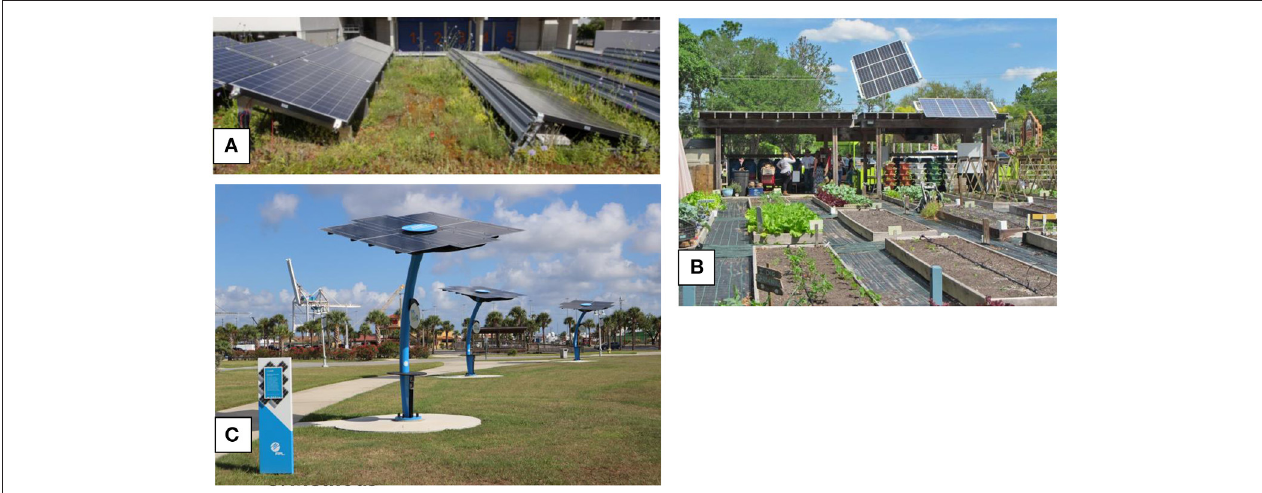
FIGURE 1 | Diverse coupled nature-intensive systems. (A) PV-green roof (Baumann et al., 2016) (B) A local solar garden (sustany.org) (C) An urban park with solar panels (solarnow.fpl.com).